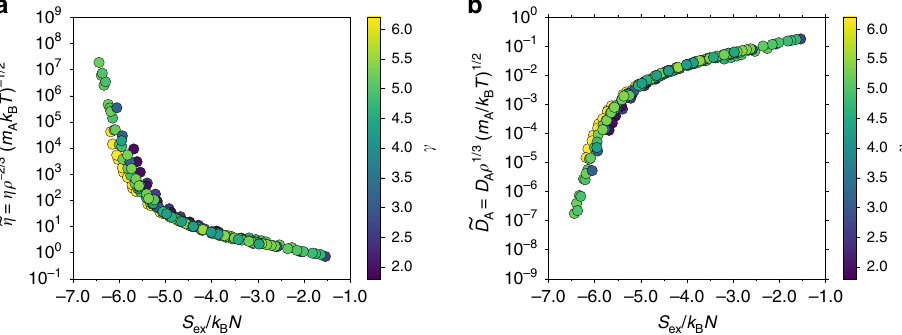
Fig. 6 Relation between the density-scaling exponent and departure from universal excess-entropy scaling. The color coding represents the value of the density-scaling exponent γ , Eq. (4). a e η as a function of S ex / k B N . b e D A as a function of S ex / k B N